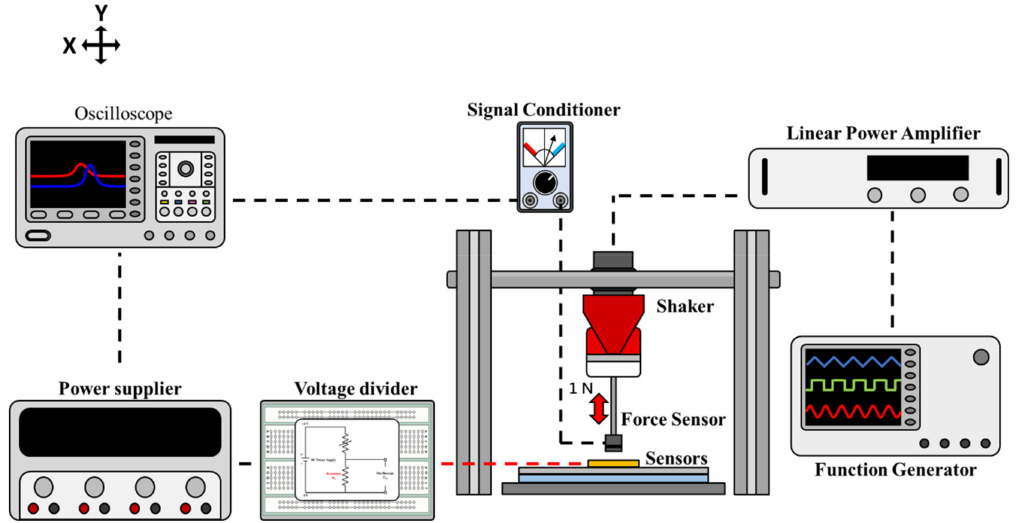
Figure 8. Schematic of the dynamic normal force measurement platform. Temperature Measurement Platform–To measure sensor reliability as a function of environmental temperature, this study uses the same normal force of 1 N and a frequency of 1 Hz to perform dynamic testing in a temperature range of − 5 ◦ C to 50 ◦ C. A